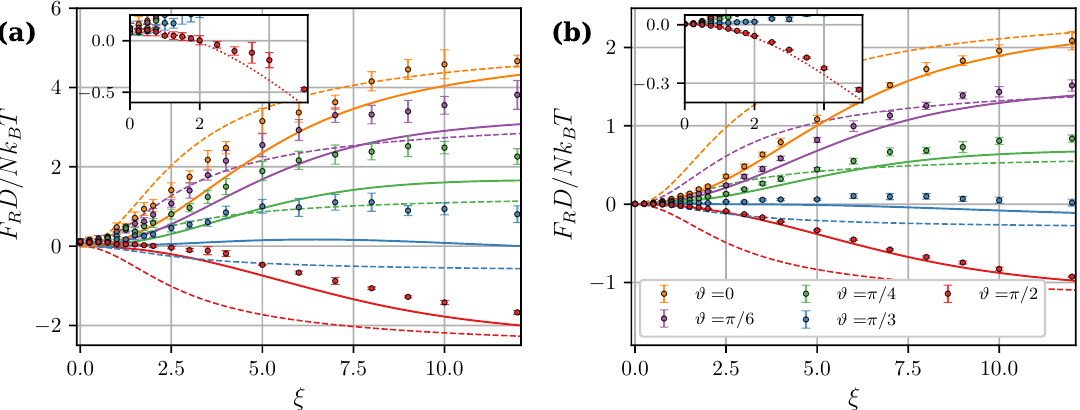
Figure 10. Magnetic central force per core as a function of the applied field ξ at λ = 3 and ϕ = 0.3. l = 1 ( a ) and 1.2 ( b ). Different colors correspond to different angles ϑ (see legend in ( b )). Symbols are simulation results for N = 100, solid curves are from MDM [Equations (23), (29)–(32)], dashed curves are from LDM [Equation (27)]. Insets show an enlarged view of the weak-field part of simulated dependencies. Dotted lines in insets are MDM predictions for ϑ = π /2 shifted upwards along the y -axis to coincide with the simulation data at ξ =